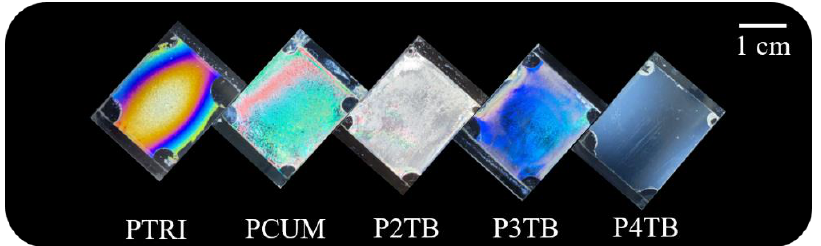
Figure 5. Photograph images of LC cells made from PTRI, PCUM, P2TB, P3TB, and P4TB films.